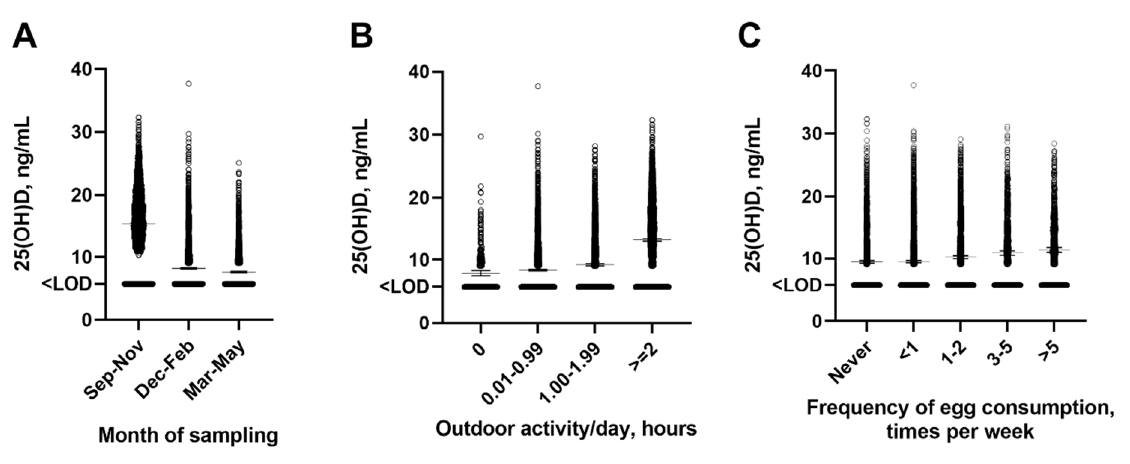
Figure 2. The 25(OH)D levels (ng/mL) Scatter Plots across Key Determinants (month of sampling ( A ), daily outdoor activity ( B ), and frequency of egg consumption ( C )). Legend: Bars and whiskers of plot represent mean and 95% CI. Respectively; LOD = limit of detection.